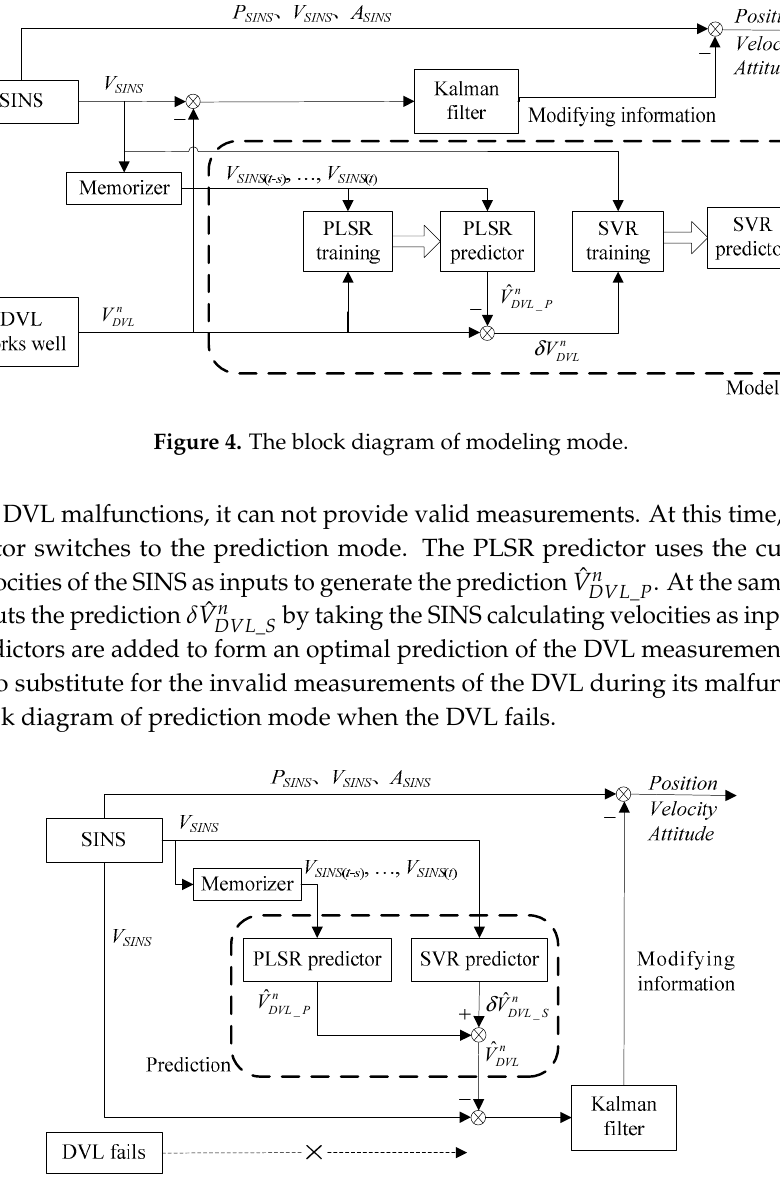
Table 1. Instrument specifications. Instruments